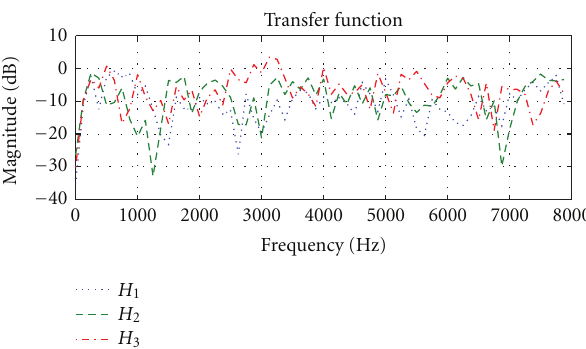
Figure 2: Magnitudes of the transfer functions for speaker three.